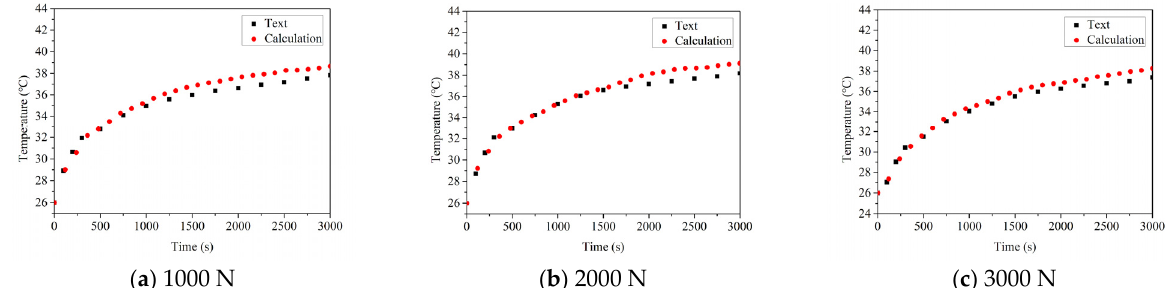
Figure 10. The influence of the load on temperature change of complete bearing.